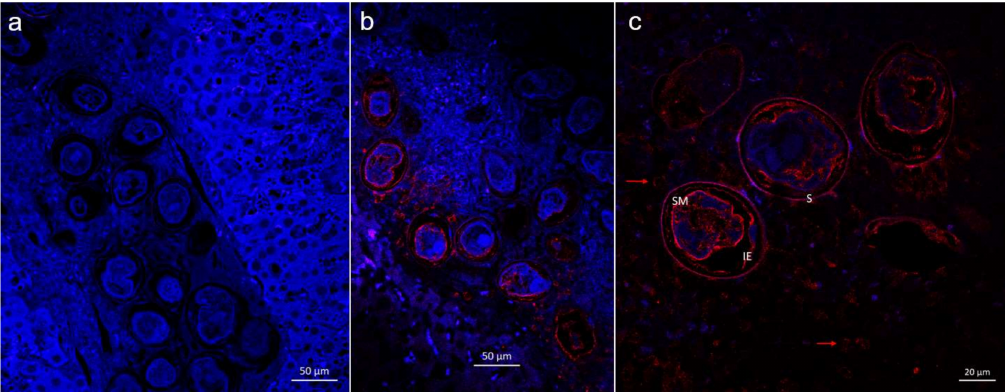
Figure 5. Immunofluorescence of SjAChE in eggs trapped in infected mouse liver probed with rabbit anti-SjAChE antibody. Immunohistological detection of SjAChE in eggs and granulomas in a S. japonicum -infected mouse liver. Sections of livers from mice infected with S. japonicum were incubated with: ( a ) naïve control rabbit serum; ( b , c ) rabbit anti-rSjAChE antiserum; and subsequently with Alexa fluor ® 647 donkey anti-rabbit IgG (red fluorescence). DAPI stained nuclei are blue. Section of schistosome eggs in a developing granuloma shows SjAChE staining (red) in eggs and around some circum-oval granuloma cells at 20 × magnification ( b ) and 40 × magnification ( c ). SM-Surface of miracidium; IE-Inner envelope; S-Shell; red arrow—circum-oval cells in the